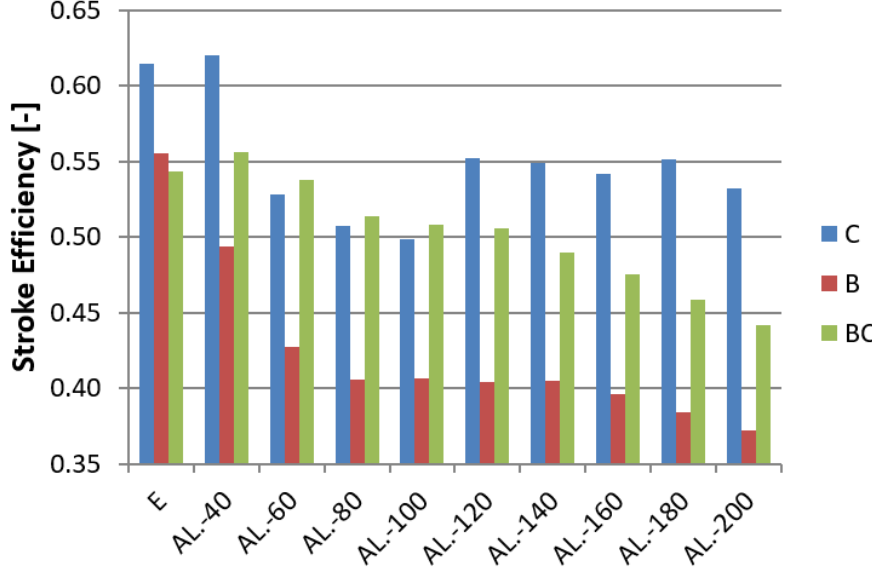
Figure 18. SE indicator for specimen filled with aluminum foam. The average force increases with foam length for all trigger shapes. The jumping trend can be witnessed, especially for the 60–100 mm range where the increase in value is Table 3. Crashworthiness indicator of aluminum foam-filled columns with different trigger.